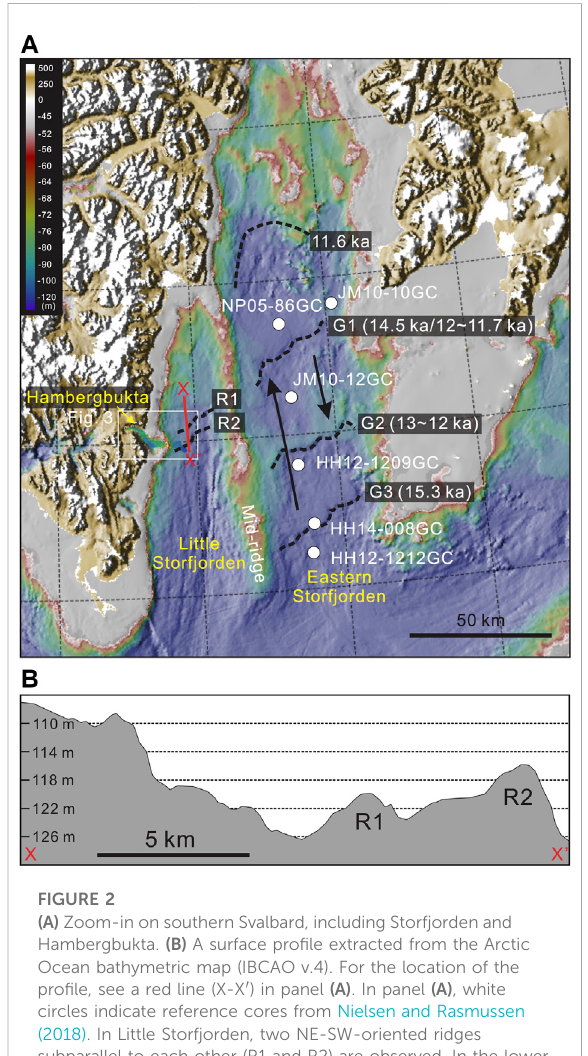
FIGURE 2 (A) Zoom-in on southern Svalbard, including Storfjorden and Hambergbukta. (B) A surface pro fi le extracted from the Arctic Ocean bathymetric map (IBCAO v.4). For the location of the pro fi le, see a red line (X-X ′ ) in panel (A) . In panel (A) , white circles indicate reference cores from Nielsen and Rasmussen (2018). In Little Storfjorden, two NE-SW-oriented ridges subparallel to each other (R1 and R2) are observed. In the lower panel, the extracted surface pro fi le shows the asymmetric morphology of two